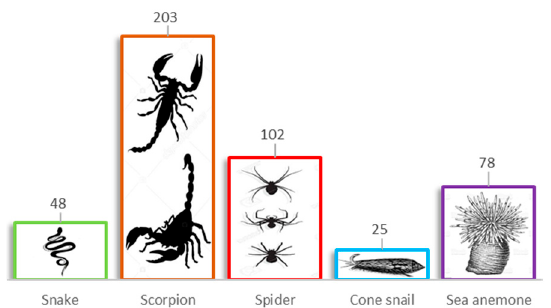
Figure 6. Peptide modulators of the voltage-gated potassium (Kv) channels. Numbers above the boxes indicate the number of toxins isolated to target Kv channels.